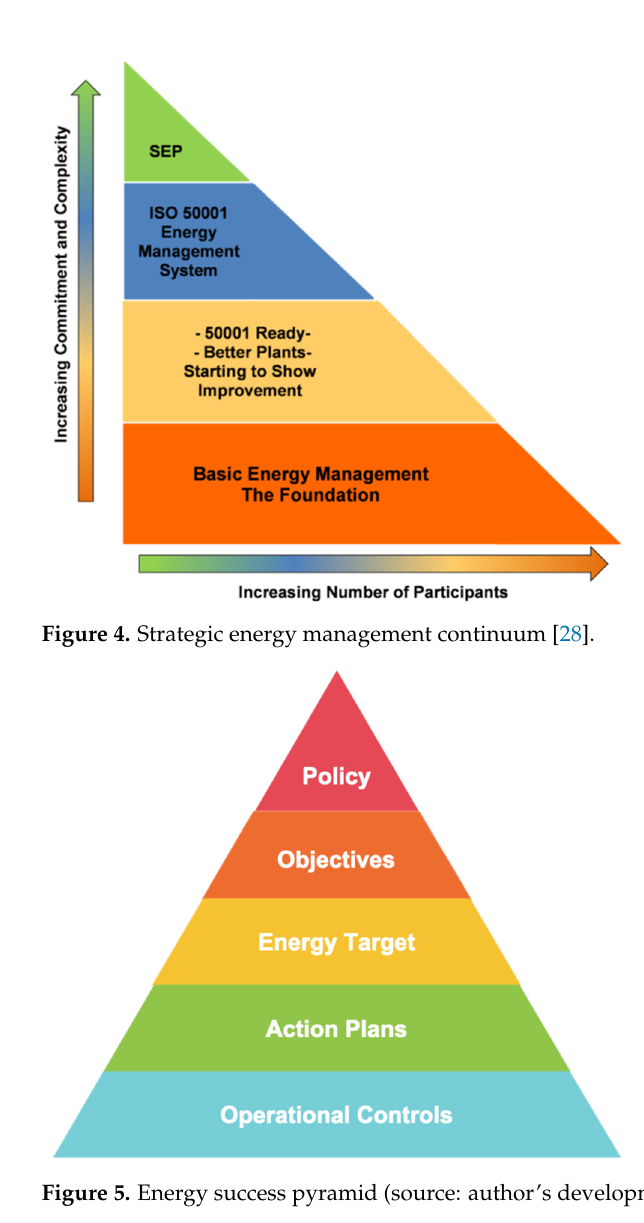
Table 4. Example answers for polling questions of Groups 1–3 (source: author’s development).